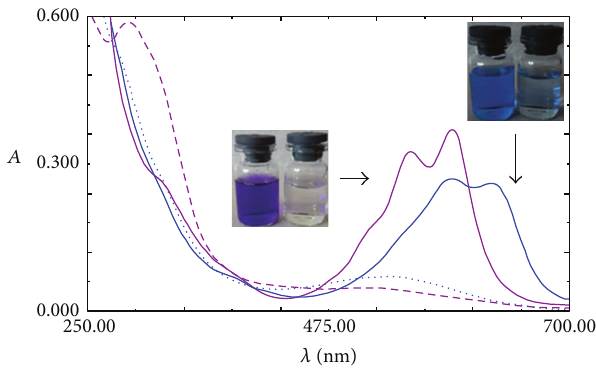
Figure 2: Absorption spectra before (solid lines) and after enzy-